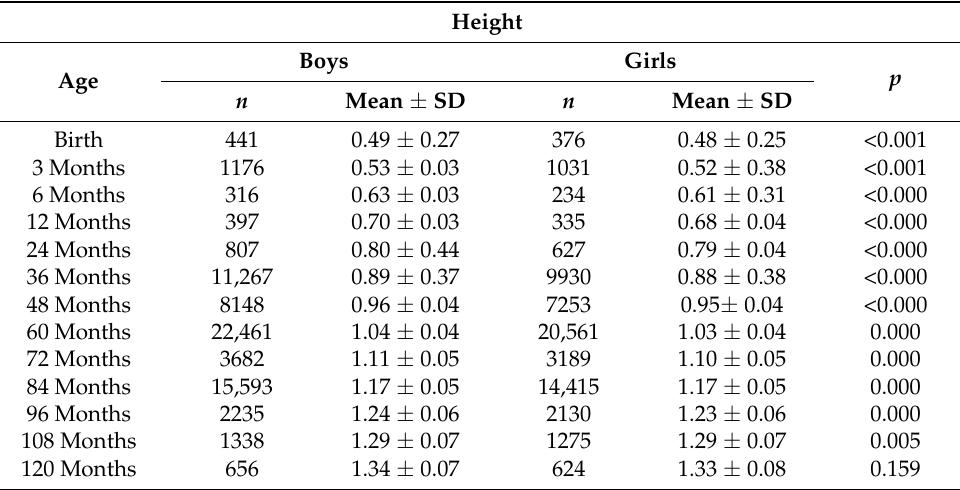
Table 3. Height (m) comparisons between boys and girls by